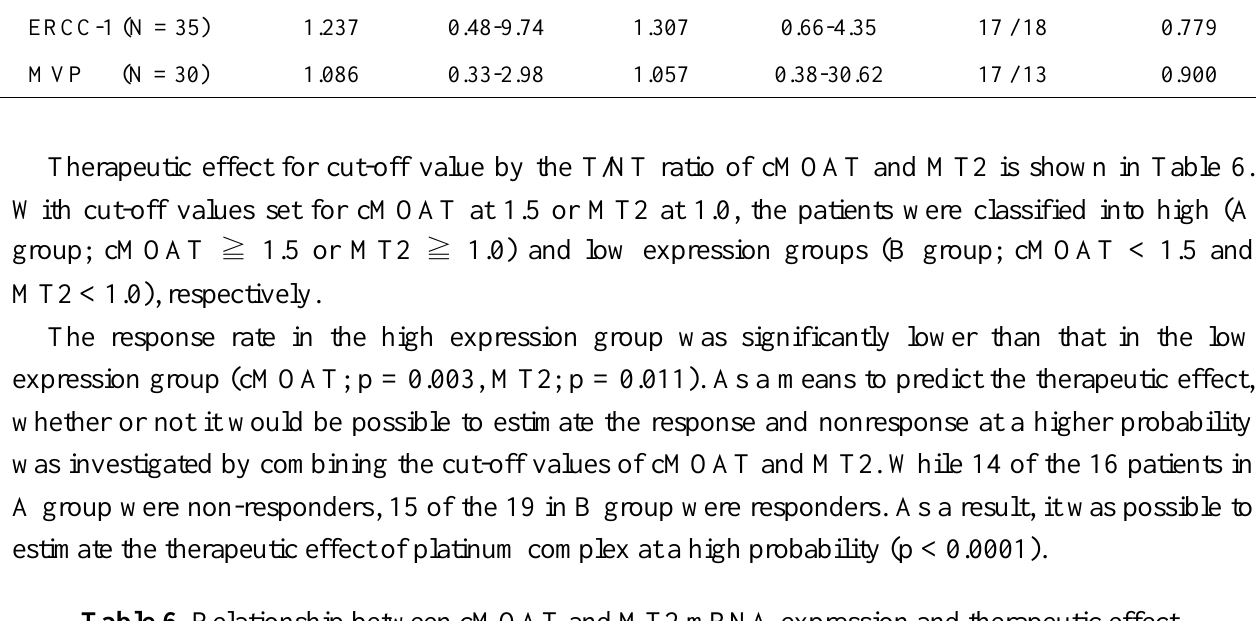
Table 6. Relationship between cMOAT and MT2 mRNA expression and therapeutic effect. No. of No. Expression of cMOAT and MT2 mRNA (T/NT ratio)